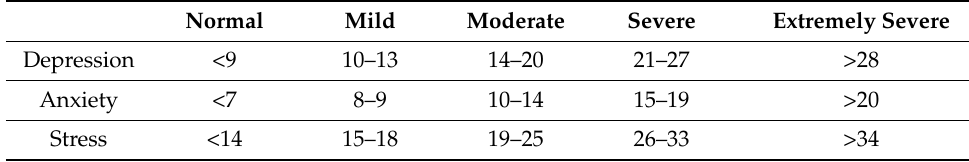
Table 1. Depression, anxiety, and stress cut-off scores. Normal Mild Moderate Severe